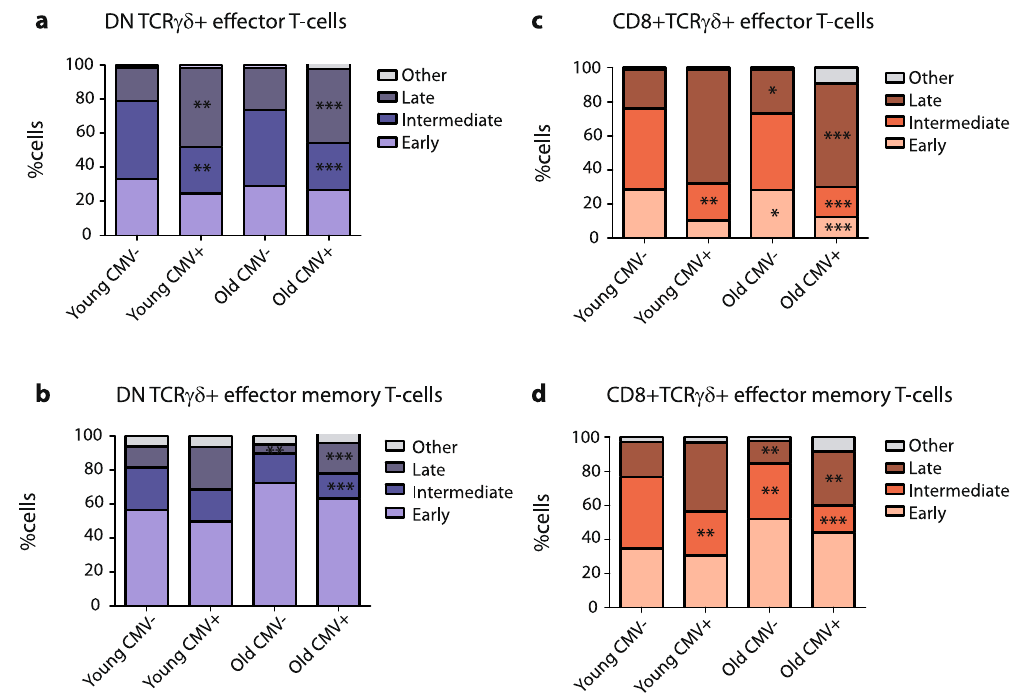
Figure 8. DN and CD8 + TCR γδ+ effector and effector memory differentiation stage distributions during ageing and in absence or presence of CMV. ( a ) Relative differentiated subset distributions of percentages of DN and ( c ) CD8 + effector and ( b ) DN and ( d ) CD8 + effector memory TCR γδ+ T-cells depicted in stacked bar plots. Significant differences between all groups was tested by a Kruskal-Wallis test, and followed by a post- Dunn’s test for correction for multiple testing. Significance for the Dunn’s test is indicated in the plots: * p < 0.05; ** p < 0.01; *** p <